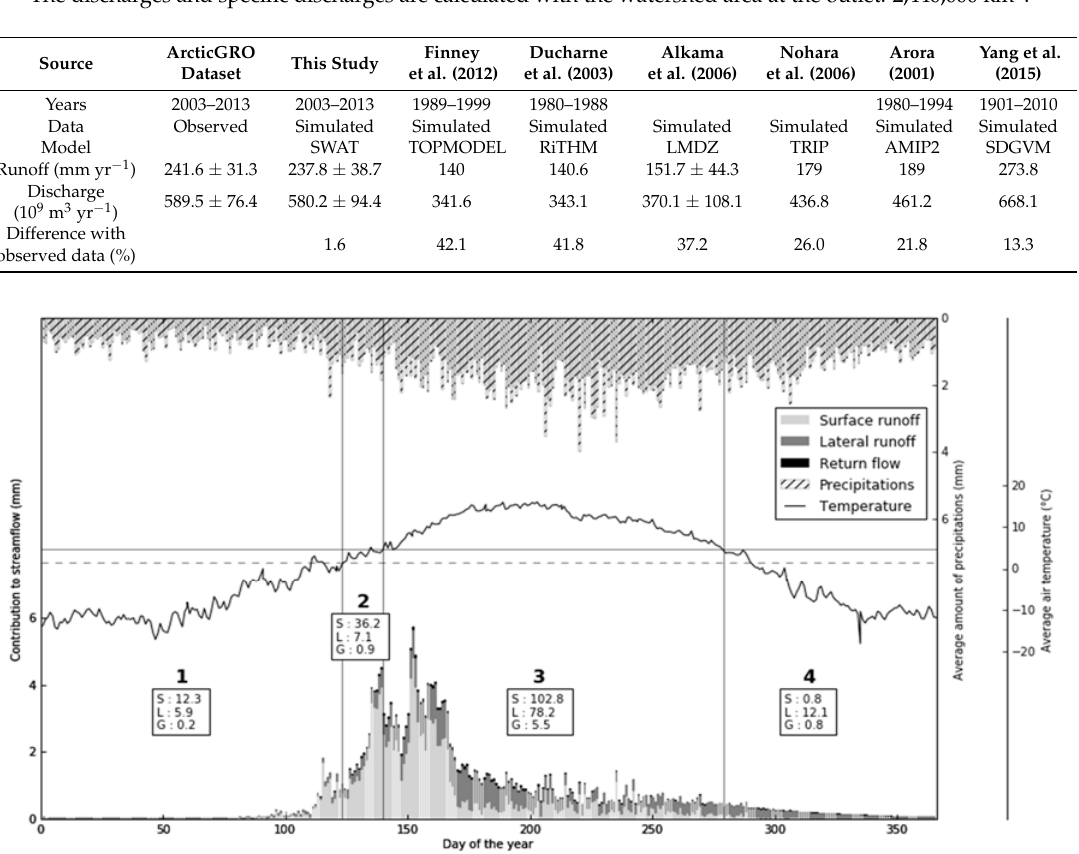
Table 2. Interannual mean of water fluxes at the Yenisei outlet compared to previous studies. The discharges and specific discharges are calculated with the watershed area at the outlet: 2,440,000 km 2 .